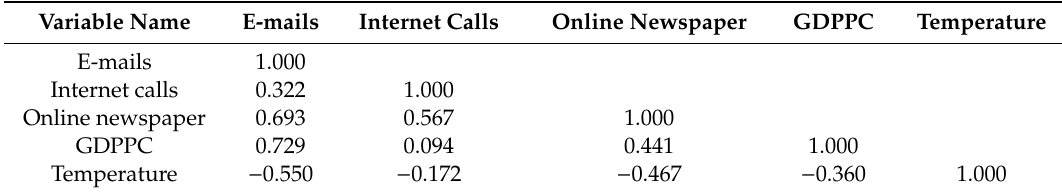
Table 3. Correlation between the variables in group 1.